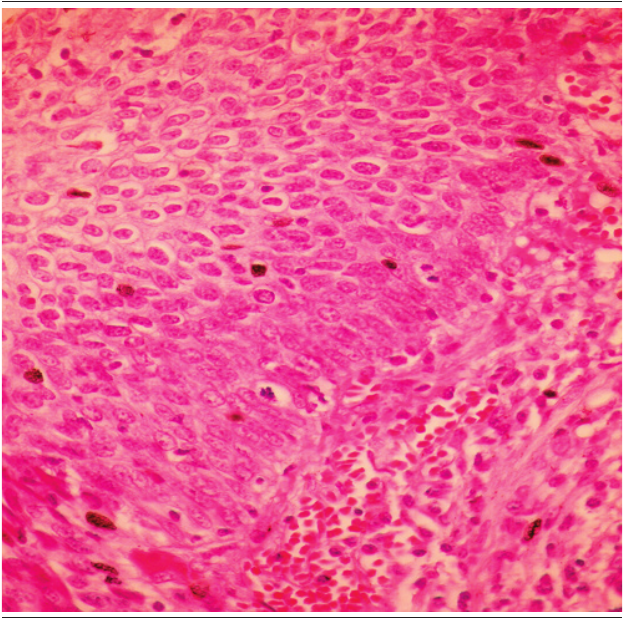
figuRE 3 − Low-grade anal lesion (HE stain, 40×) Histological section of anal canal with immature cells occupying the lower third of the epithelium, with atypical maturating cells, and koilocytosis in the upper two-thirds. HE: hematoxylin and eosin.